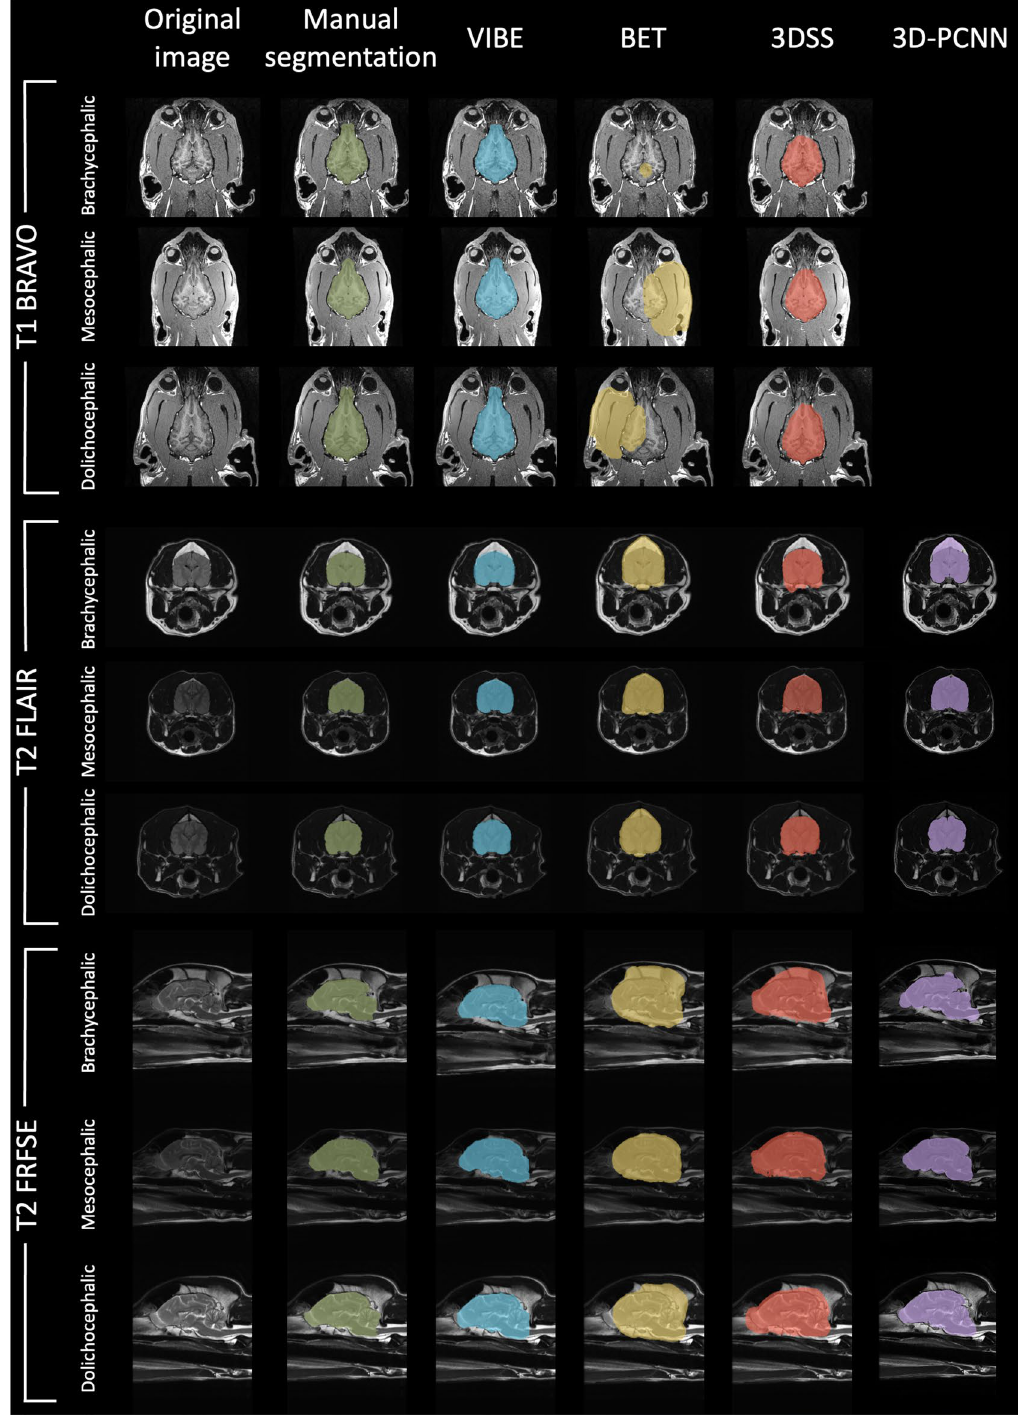
Figure 4. Dogs cohort: comparison of the brain extraction results for each segmentation technique. From left to right: Original image, Manual segmentation, VIBE, BET, 3DSS, and 3D-PCNN. Different sequences (T1 BRAVO, T2 FLAIR and T2 FRFSE) are shown, as well as a sample of each brain shape (brachycephalic, mesocephalic and